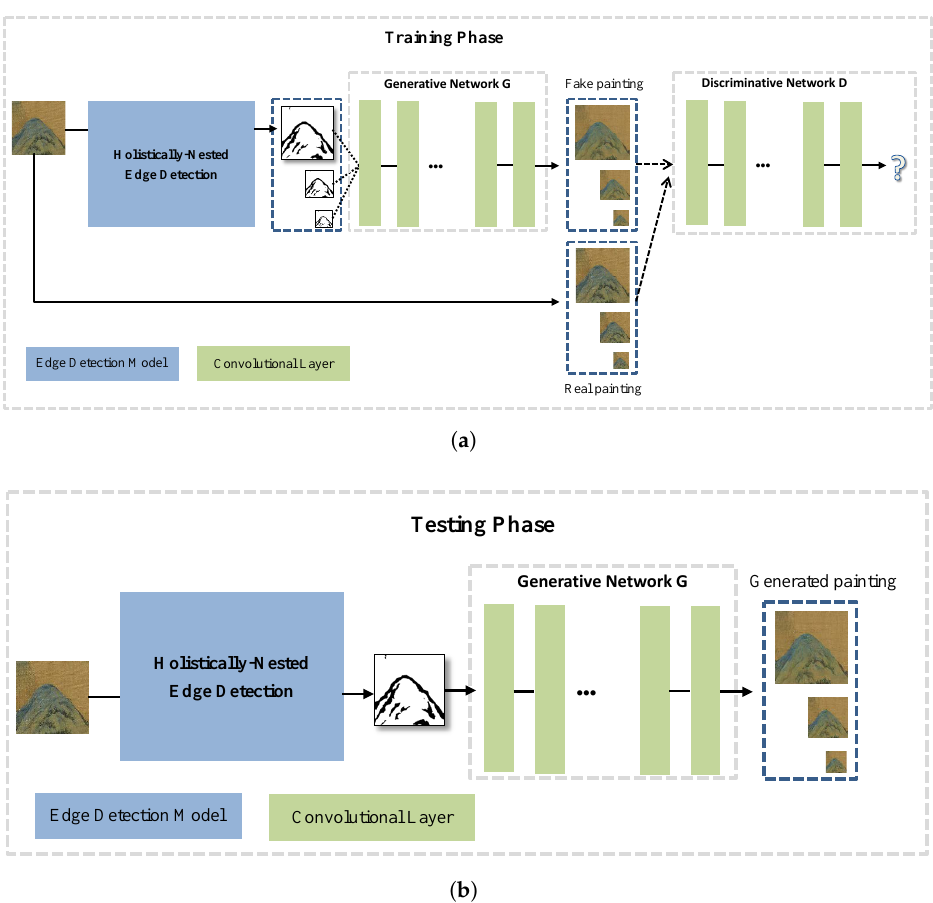
Figure 2. Overview of the proposed approach. Training a multiscale deep neural network that can generate a Chinese painting from a sketch. We use an edge detection model to produce the input sketch. ( a ) By training, the discriminative network can make a distinction between the real and fake paintings, and the generative network aims at fooling the discriminative network by training; ( b ) after training, the generator can create realistic